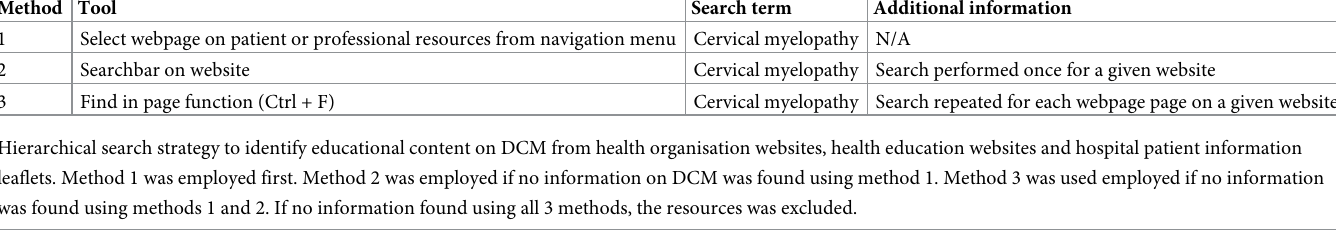
Table 1. Search strategy for organisations, health education websites and hospital patient information leaflets. Method Tool